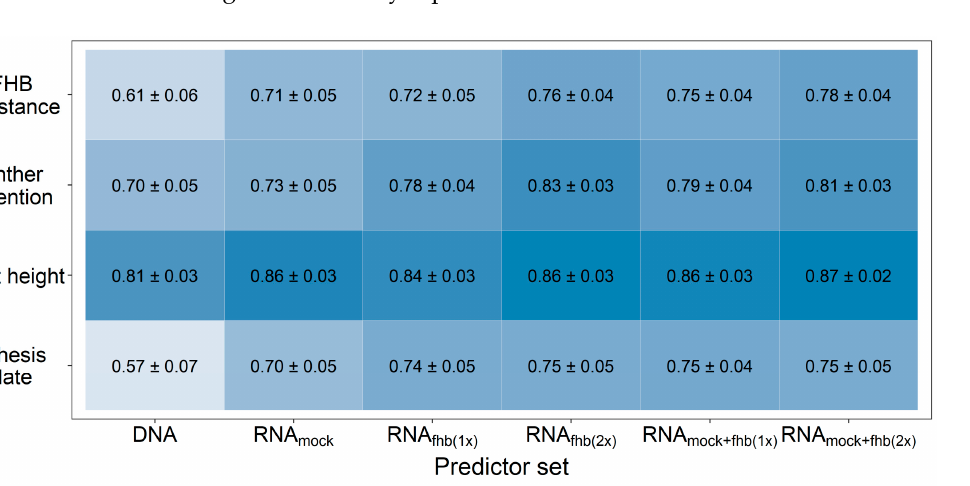
Figure 1. Prediction ability for FHB resistance, anther retention, plant height, and anthesis date using different predictor sets for a genomic prediction with 10,084 SNP markers (DNA) or 90,093 expressed genes (RNA). The usage of individual feature matrices of the transcriptomic data obtained from mock-treated plants (RNA mock ) or Fusarium -treated plants (RNA fhb(1x) ) was compared with a combination from both Fusarium -treated replications (RNA fhb(2x) ) or from one mock-treated and one Fusarium -treated replicate at time (RNA mock+fhb(1x) ) as well as the integration of gene expression data from all treatment-by-replication combinations (RNA mock+fhb(2x) ). Darker coloring indicates a higher average prediction ability.